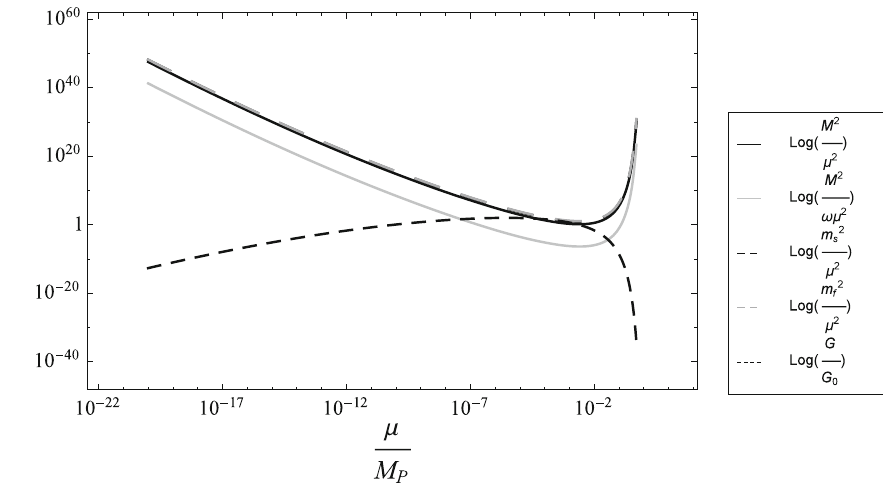
Fig. 14 The running of various induced masses and the induced Newton constant. For this we took f 2 ∗ = 10 − 8 , λ ∗ = 0 . 1, ξ ∗ = 10 5 . We took ρ ∗ = 1 . 5 and (cid:2) = 10 − 16 , which gave y t ∗ = 0 . 46 and ω ∗ = 3 . 18 × 10 6 . Here μ is the running energy